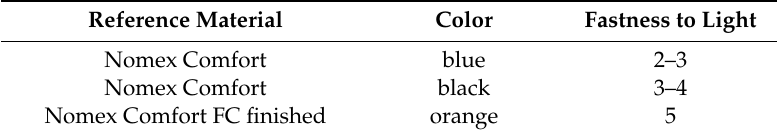
Table 3. Fastness to light of conventionally dyed m-aramid fibers.